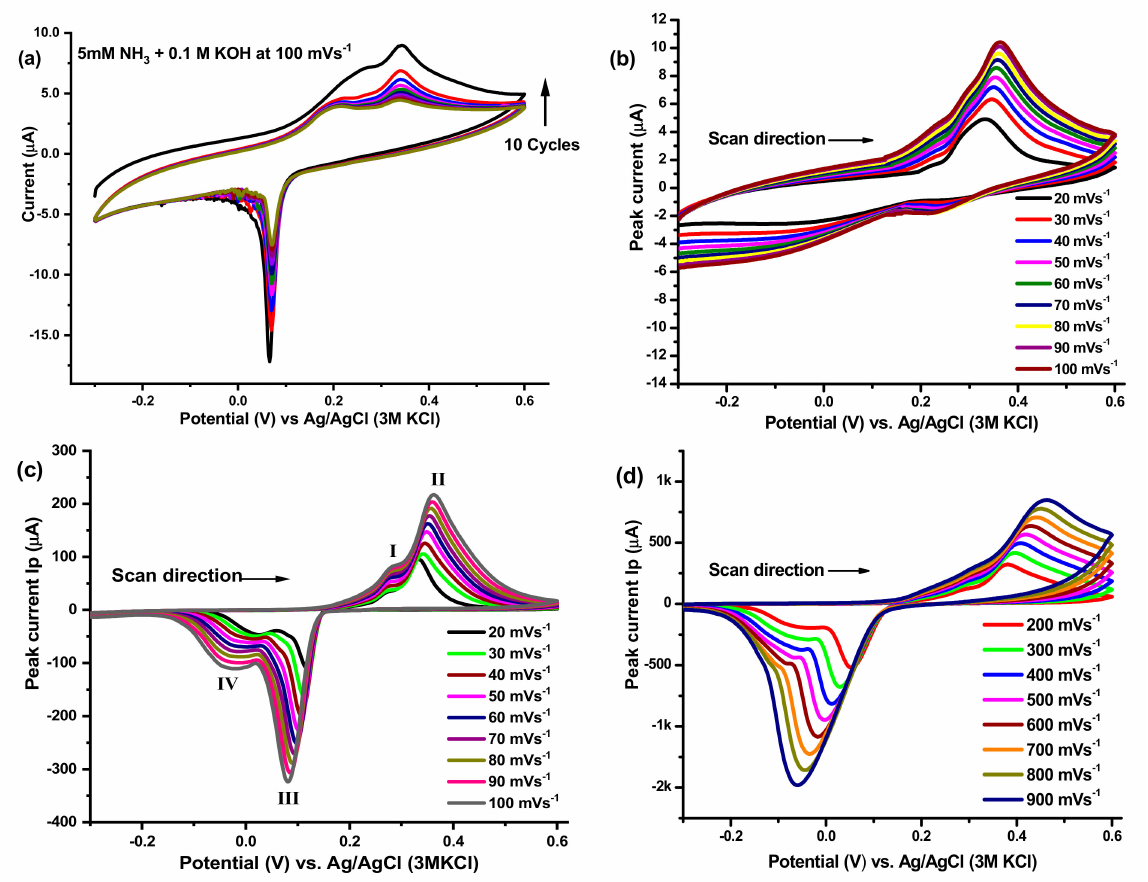
Figure 8. ( a ) Ten cycles in 5m mM NH 3 + 0.1M KOH at Ag 2 O (2) –PrO 2(8) / γ -Al 2 O 3 /GC. Scan rate variation for ( b ) PrO 2(10) / γ - Al 2 O 3 , ( c ) Ag 2 O (6) –PrO 2(4) / γ -Al 2 O 3 at low scan rates and ( d ) Ag 2 O (6) –PrO 2(4) / γ -Al 2 O 3 , at high scan